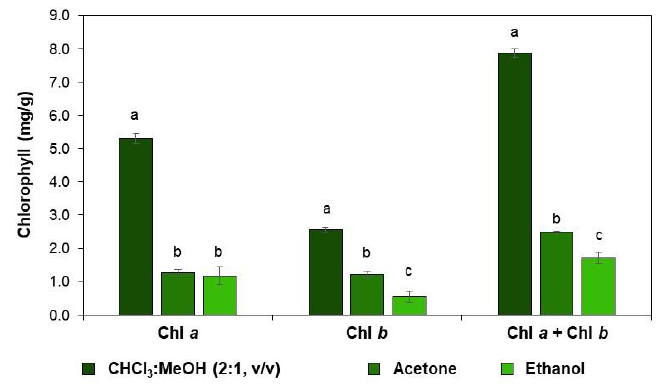
Figure 2. Extraction yield of chlorophyll a (Chl a , mg/g), chlorophyll b (Chl b , mg/g), and total chlorophylls (Chl a + Chl b , mg/g) from C. vulgaris biomass, using chloroform:methanol (2:1, v / v ), acetone, and ethanol (96%). Mean values ± SD, n = 9. The different characters above the bar indicate statistical differences ( p < 0.05) between compared groups (One-Way ANOVA, Tukey’s multiple comparisons test).